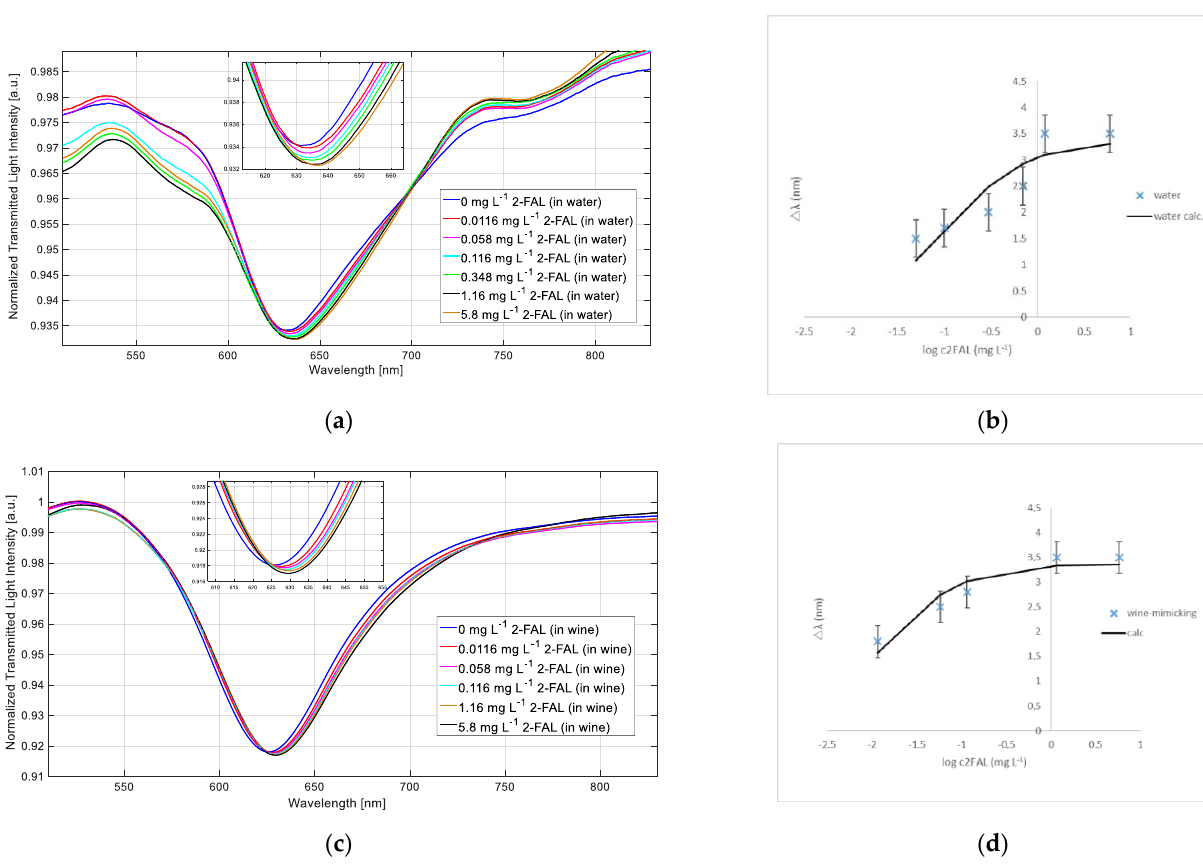
Figure 6. ( a ) SPR spectra of the SPR-MIP sensor at different 2-furaldheide (2-FAL) concentrations in water; ( b ) SPR wavelength shift vs. concentration of 2-FAL in a water solution and the calculated continuous curve; ( c ) SPR spectra of the SPR-MIP sensor at different 2-FAL concentrations in wine-mimicking solution; ( d ) SPR wavelength shift vs. concentration of 2-FAL in wine-mimicking solution and the calculated continuous curve. Vertical bars in ( b , d ) correspond to the standard deviations (error bars).